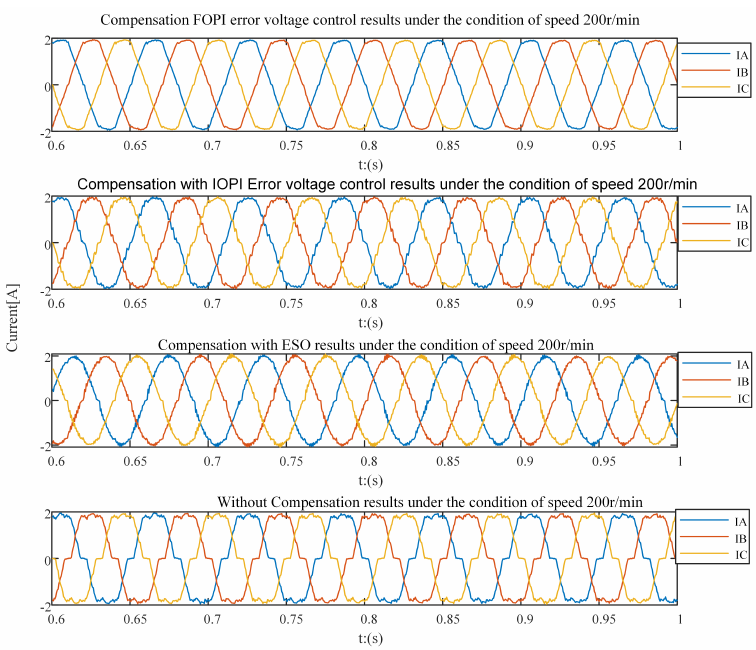
Figure 30. Comparison of three-phase current response under 200 r/min speed